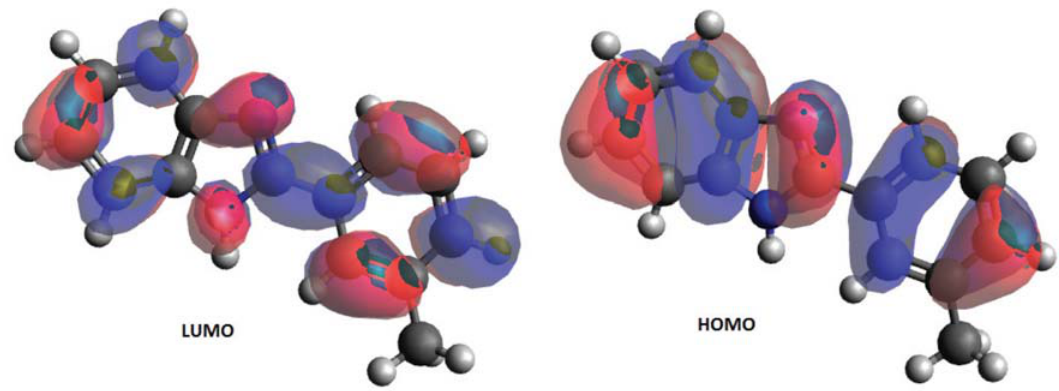
Figure 8. The atomic orbitals compositions of the frontier molecular orbital for compound